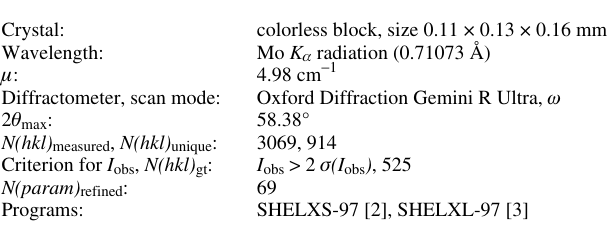
Table 1. Data collection and handling.